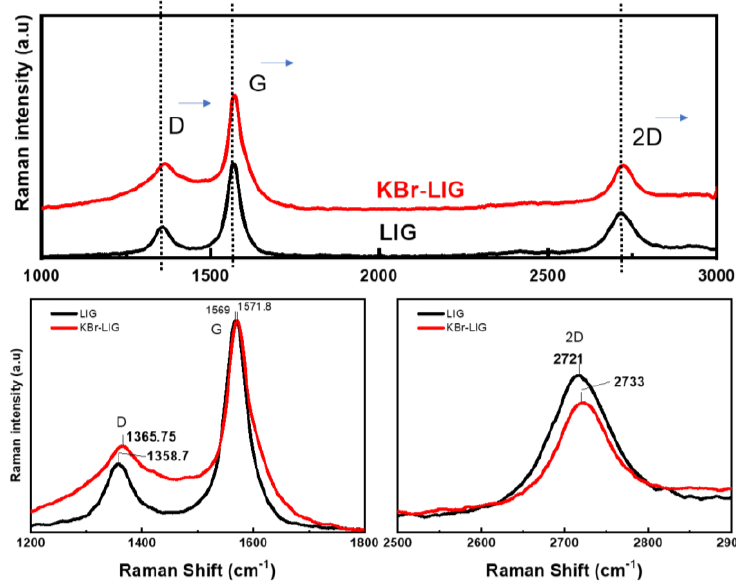
Figure 2. The measured Raman spectra of LIG and KBr-LIG samples.